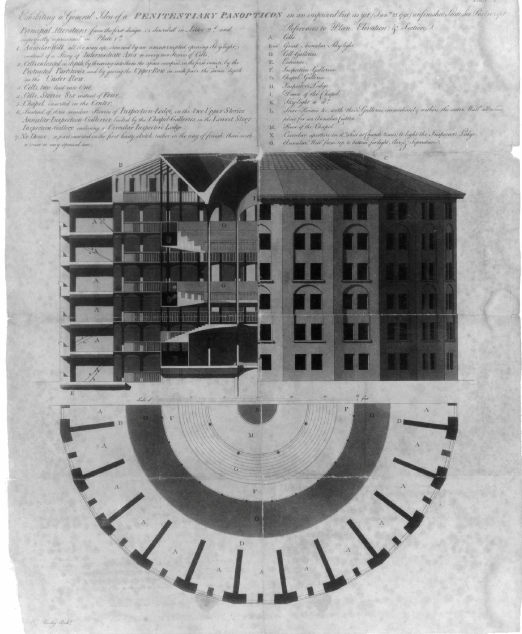
Figure 3. The Penitentiary Panopticon, by J. Bentham, 1787. This is the improved 1791 project drawn up by W.